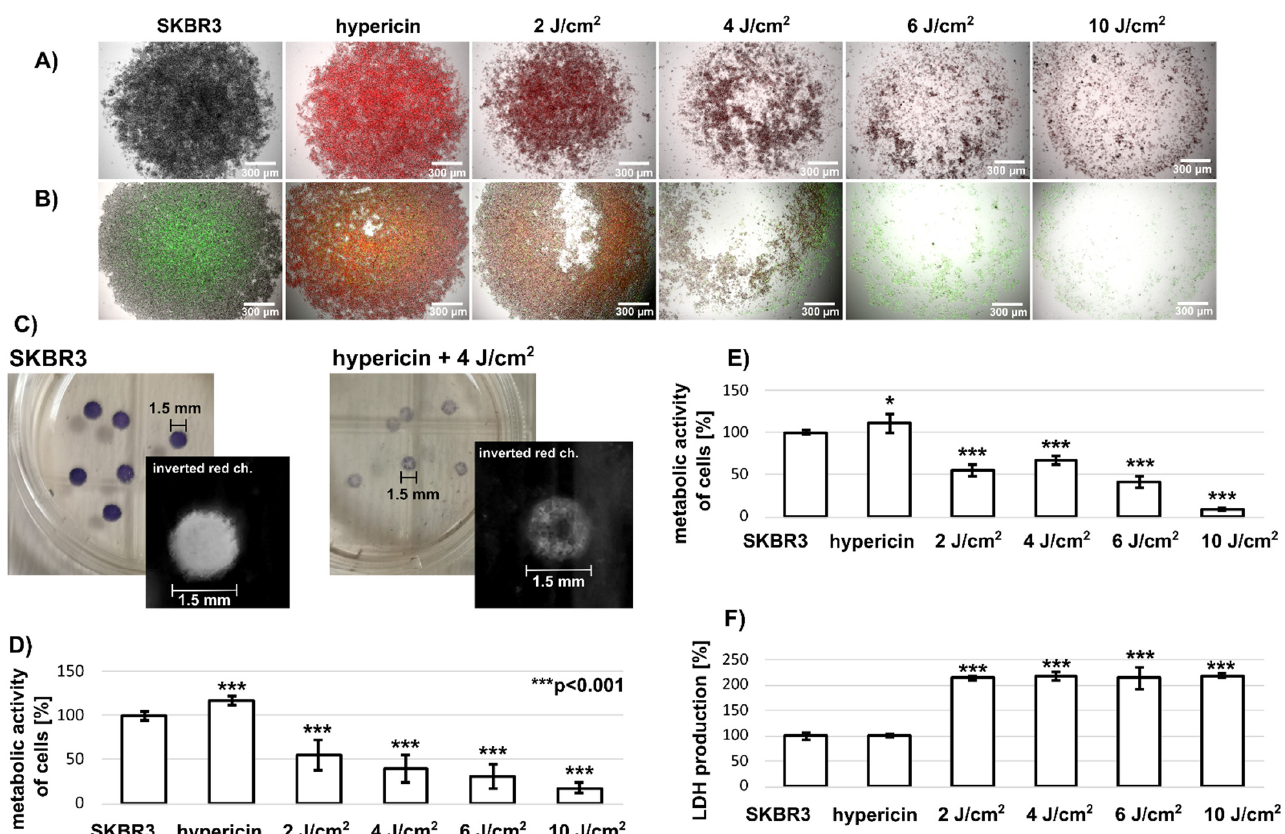
Figure 1. ( A ) Microscopical images of SKBR3 spheroids in the presence and absence of 500 nM hypericin (red fluorescence) and 24 h after application of different light doses 2–10 J/cm 2 . Scale bar represents 300 µ m. ( B ) Caspase-3 levels in these cells detected with NucView ® 488 Caspase-3 substrate. Scale bar represents 300 µ m. ( C ) Representative images of SKBR3 spheroids after MTT application (case without treatment and after 4 J/cm 2 ). The black and white images represent inverted red channels of RGB images. Scale bar represents 1.5 mm. ( D ) Analysis of the intensities of white circles (related to formazan production in the cells) shows the metabolic activity of cells in spheroid. ( E ) Metabolic activity of cells in spheroids measured by dissolving formazan in DMSO. ( F ) LDH production of SKBR3 cells in spheroids. The degree of significant difference was analysed by one-way method ANOVA, * p < 0.05 and *** p < 0.001. All experiments were performed in triplicates. The heterogeneous distribution of caspase-3 in SKBR3 spheroids was clearly evident from the images. In addition, flow cytometry was used to determine different cell popu- Phototoxicity of PDT to cells in this formation was determined by adding MTT to the cell culture medium. Compact aggregates of SKBR3 cells were highlighted by a purple color in Figure 1C. Donut-shaped aggregates were identified after a light dose of 4 J/cm 2 . Phototoxicity associated with metabolic activity of these cells was assessed using inverted 8-bit grayscale images (Figure 1C: black and white insets from each aggregate). This method revealed a decreasing metabolic activity of cells after PDT (2–10 J/cm 2 ) (Figure 1D).